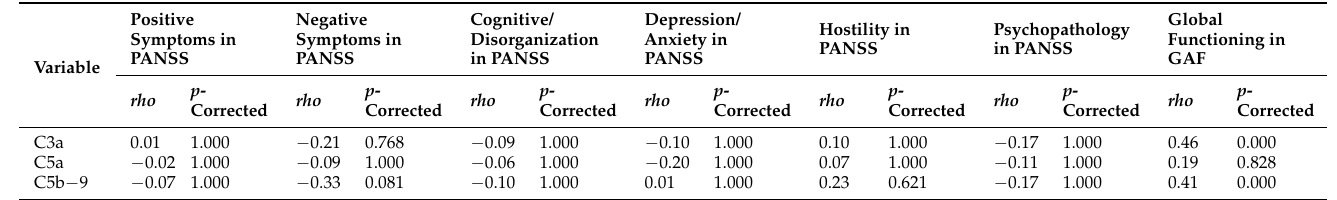
Table 3. Correlations between complement components, psychopathological dimensions and global functioning in schizophrenia